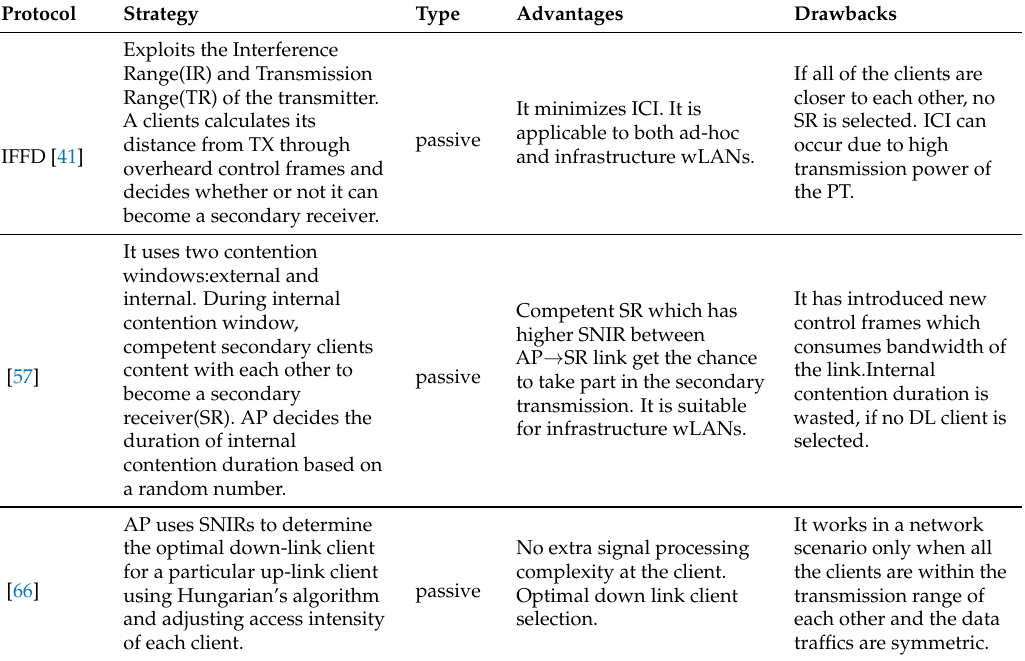
Table 6. Comparisons among various solutions of inter-client interference cancellation in full duplex MAC protocols and their